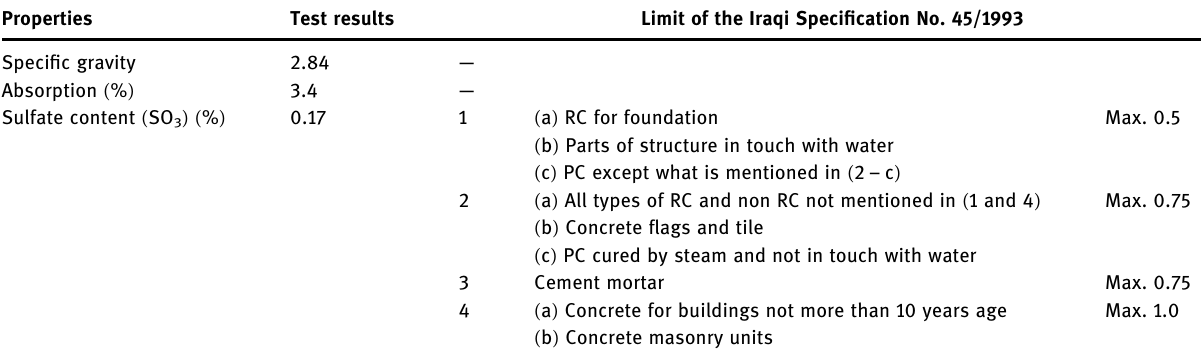
Table 4: Physical properties of the fi ne aggregate*